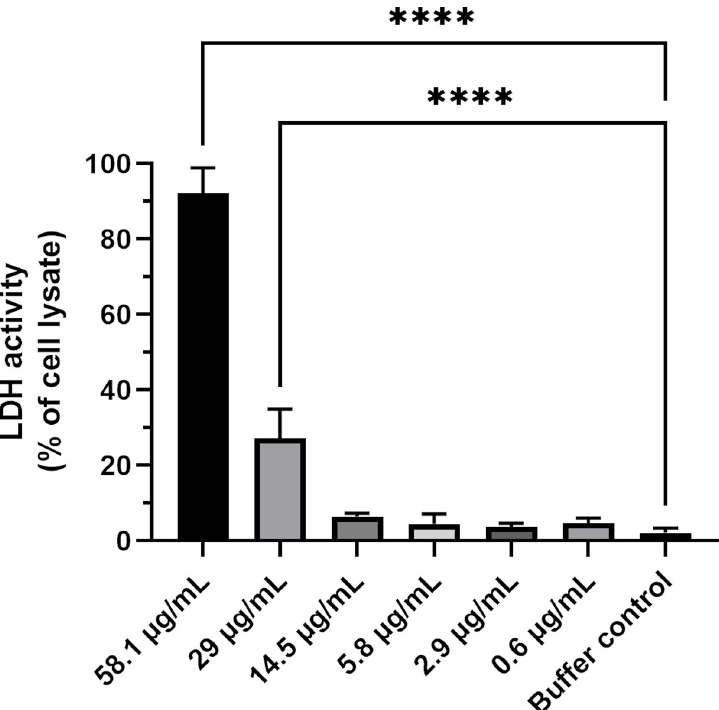
Fig 3. LDH assay. The LDH assay was performed on samples taken from the apical side of Caco-2 cell monolayers exposed to either transport buffer or different concentrations of JBC 1847 (0.6 μ g/ml- 58.1 μ g/ml) or purified water. Data is shown as assay response (absorbance value at 492 nm) of the different samples relative to the mean response measured for samples from the Caco-2 cell monolayer exposed to purified water (mean ± SD). All samples were run in triplicate. Responses measured from Caco-2 cell monolayers exposed to 58.1 μ g/ml and 29 μ g/ml were significantly higher in buffer control in an ordinary one-way